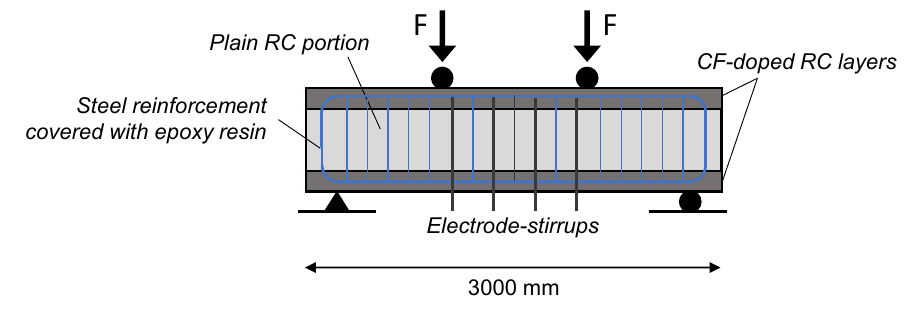
Figure 4. RC beam strengthened by CF-doped RC layers (adapted from [75]).